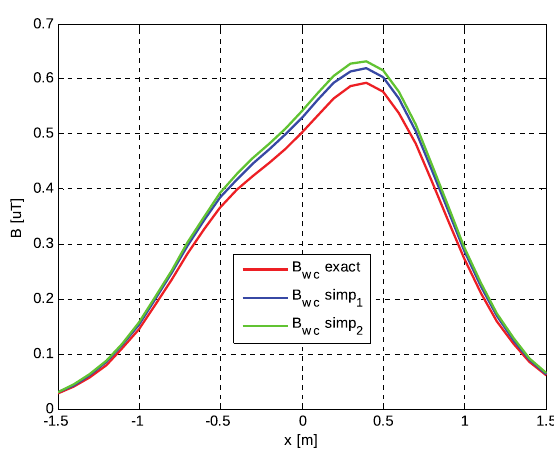
Figure 9. B WC , B WC,simp 1 , B WC,simp 2 versus horizontal distance x for the second case study.